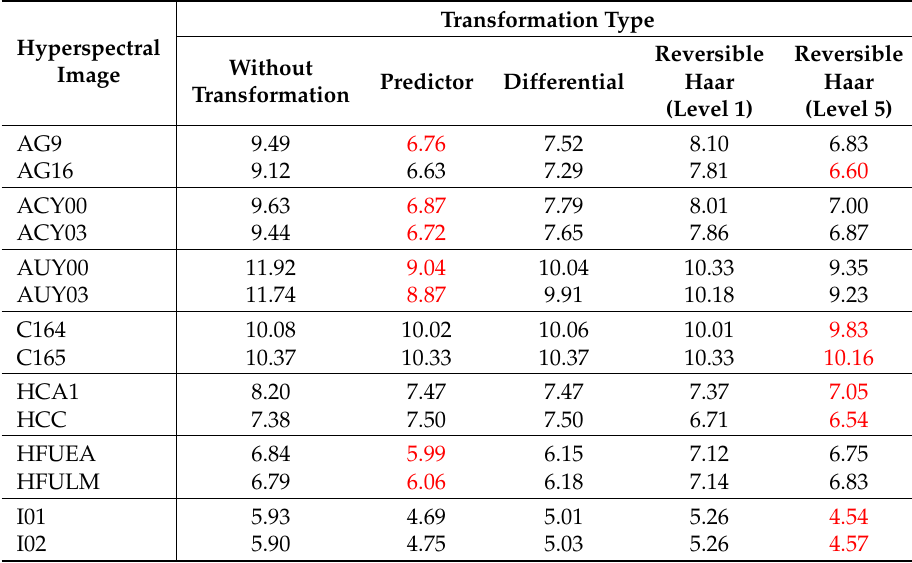
Table 8. A rate (bpppb) comparison using different transformed methods: predictor, differential, reversible Haar level 1 and reversible Haar level 5 on k 2 -raster. The optimal values are highlighted in red. Transformation Type Hyperspectral Reversible Reversible Without Image Haar Predictor Differential Haar Transformation (Level 5) (Level 1) AG9 9.49